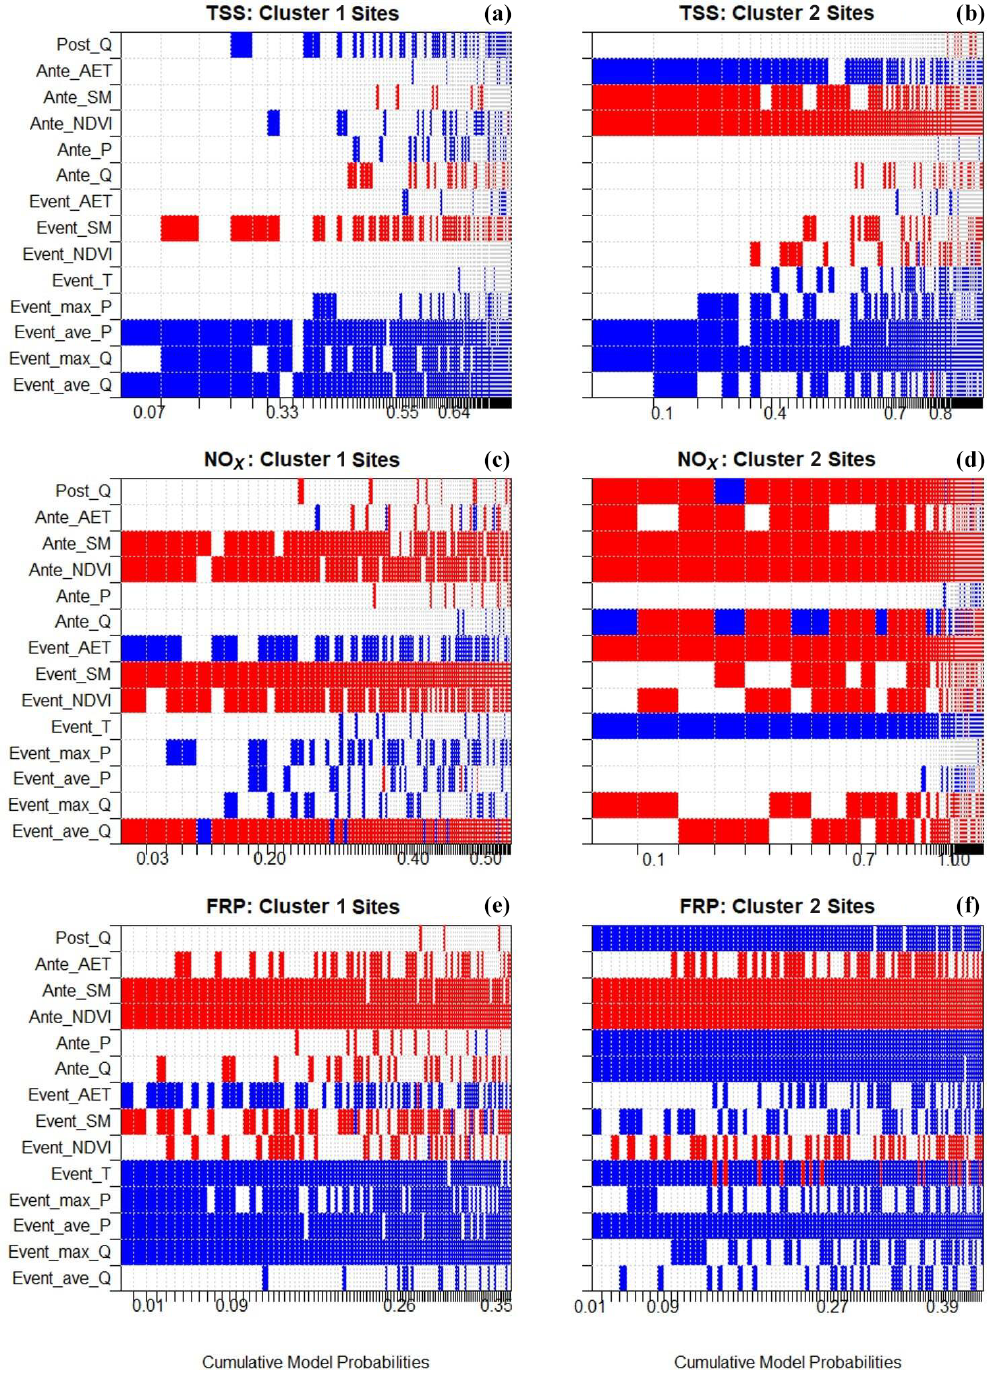
Figure 5. Comparison of BMA model coefficients and cumulative model probabilities (only the first 100 models ranked according to the highest probability are shown) between cluster 1 (wet – a,c,e ) and cluster 2 (dry – b,d,f ) sites for (a) TSS, (b) NO x and (c) FRP. Each column in the heat map represents the one specific model (ranked from the highest model probability from left to right), and the width of the column is normalised by the posterior model probability (i.e. the widest columns indicate models with the largest increase in probability compared to the next most probable model). The colour indicates the direction of the coefficients; red is negative, and blue is positive. The coefficient value was averaged across the posterior median value of the site-specific coefficient within each cluster (effect size, θ n,j , in Eq. 6). The definitions of the abbreviations of each predictor on the y axes are given in Table